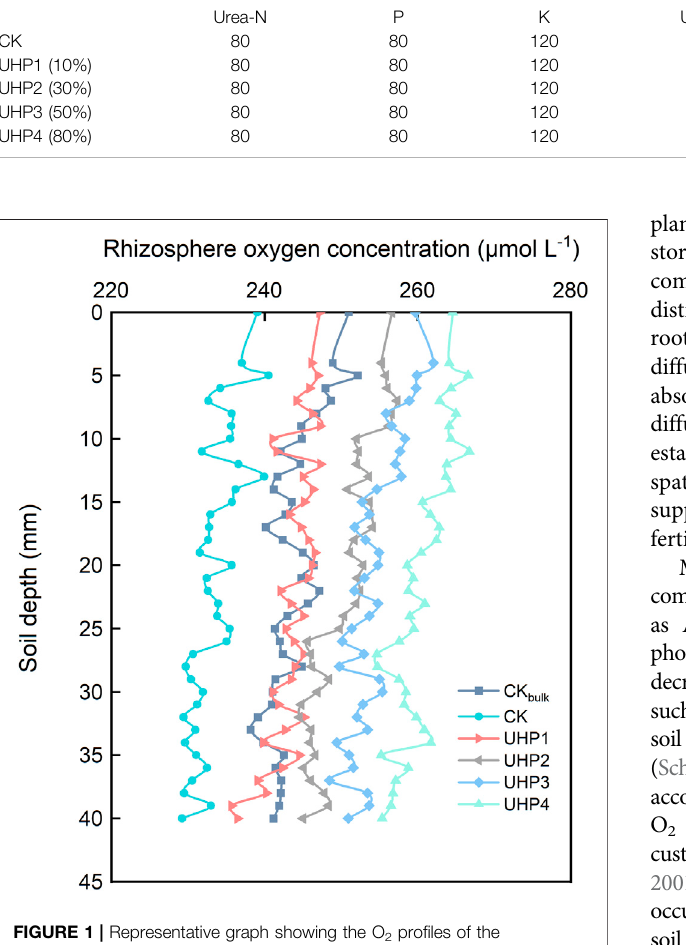
Frontiers in Environmental Science |